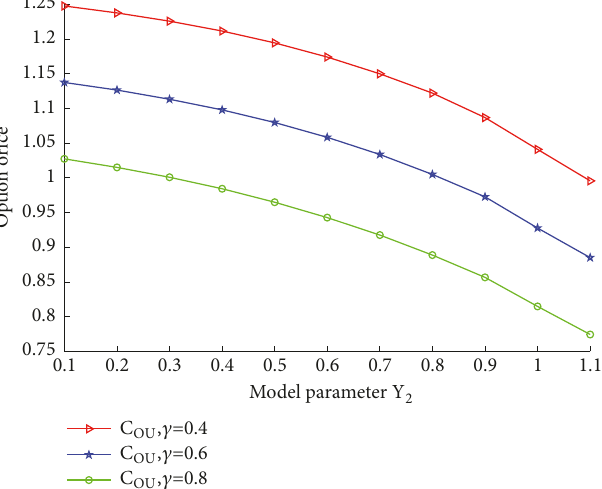
Figure 11: The effect of 𝑌 2 on the vulnerable option